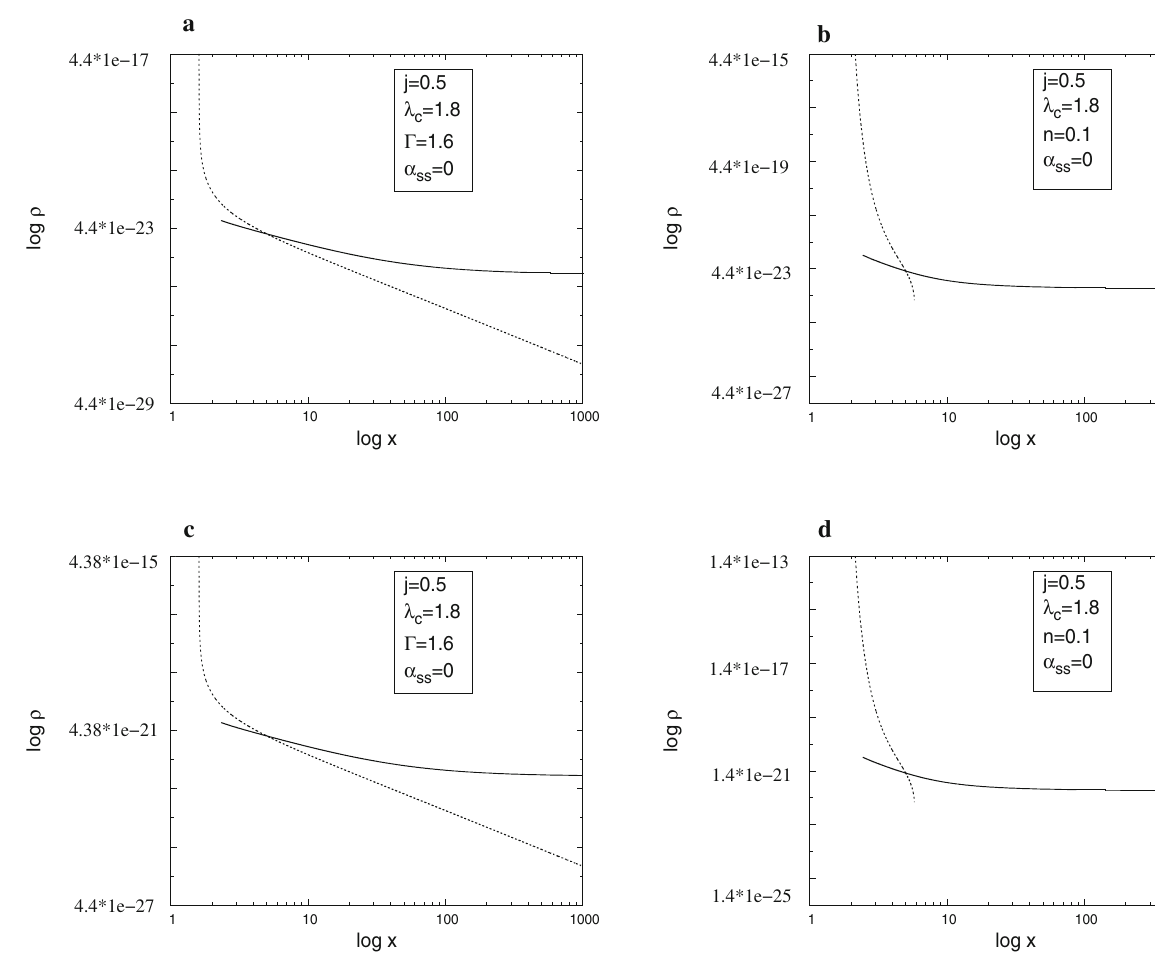
Fig. 5 a , c Plotsof log (ρ) vs log ( x ) fornonviscous accretiondiscflow around a non-rotating BH for adiabatic case using NFW and Einasto profile respevctively. b , d Plots of log (ρ) vs log ( x ) for nonviscous